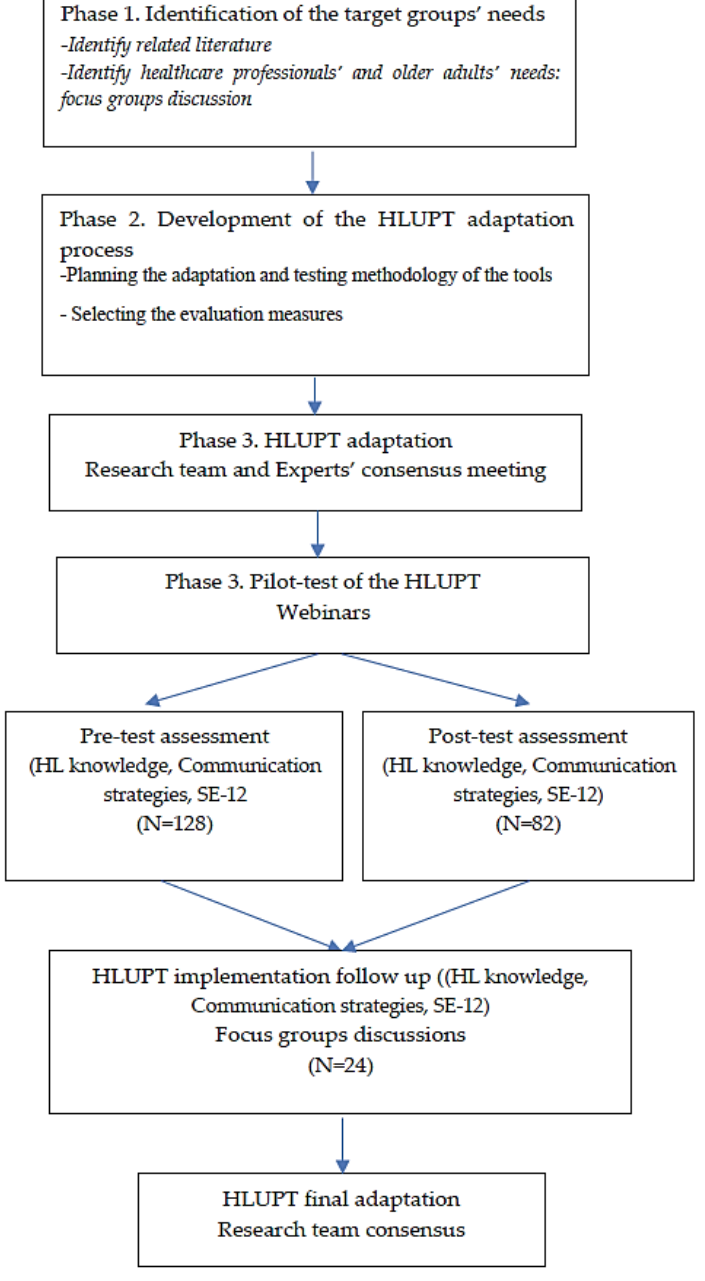
Figure 1. HLUPT cultural adaptation